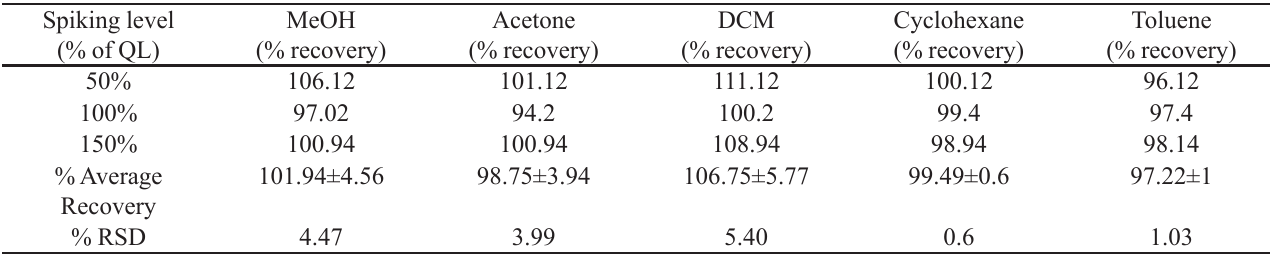
TABLE III - Accuracy data for different residual solvents Spiking